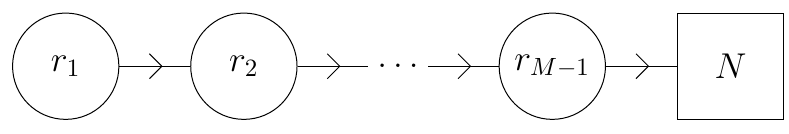
Figure 11 . The 3d quiver which lifts to the generic surface operator upon gauging the SU( N ) (cid:13)avour symmetry represented by the square node at the